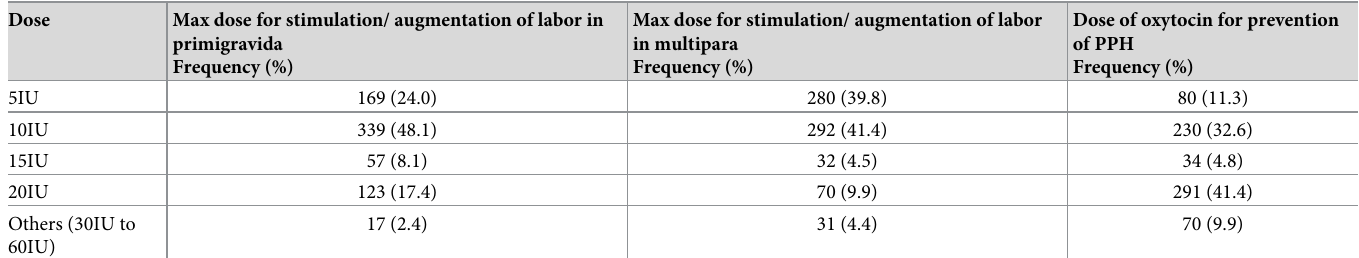
Table 6. Use and dosage of oxytocin for various obstetric indications. Dose Max dose for stimulation/ augmentation of labor in primigravida